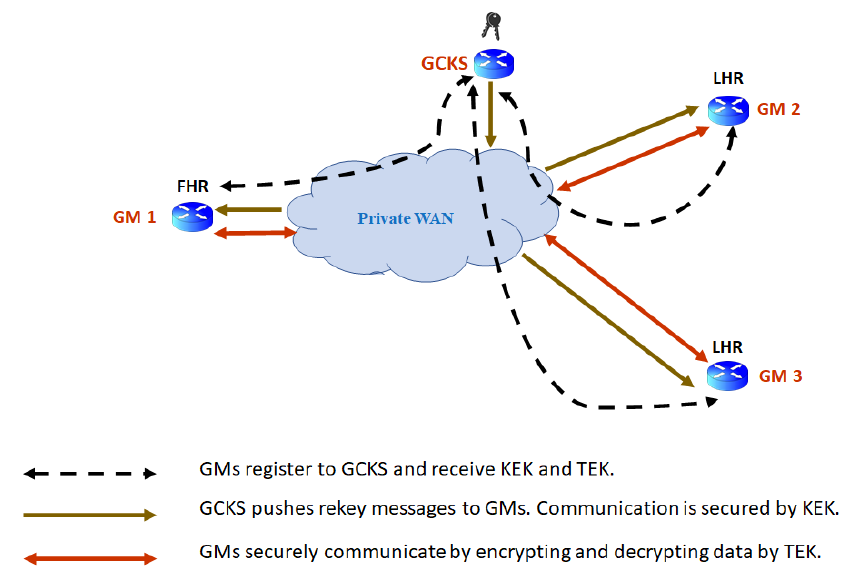
Figure 12. GDOI components (GCKS and GMs) in GET VPN architecture.